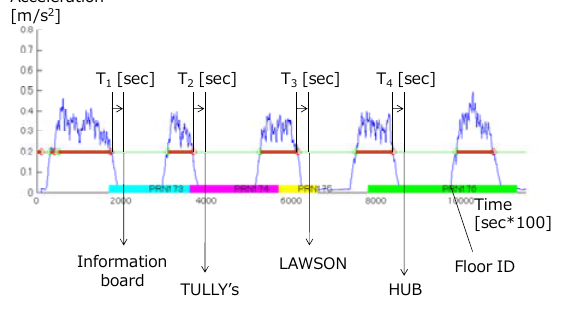
Figure 8. Result of status translation and spatial data